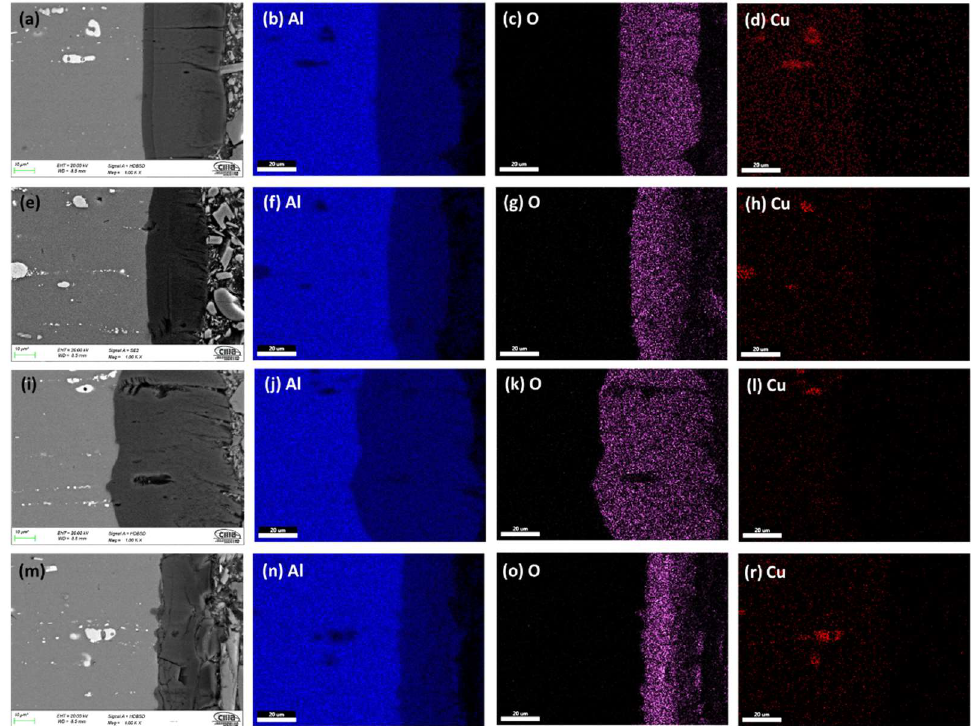
Figure 3. SEM-BSE cross-section of anodized samples of AA2024 at 3 A/dm 2 : ( a ) 3A C1M S5, ( e ) 3A C1M S10, ( i ) 3A C1M, and ( m ) 3A S1M. Element content; Aluminum ( b , f , j , n ), Oxygen ( c , g , k , o ), and Copper ( d , h , l , r ).